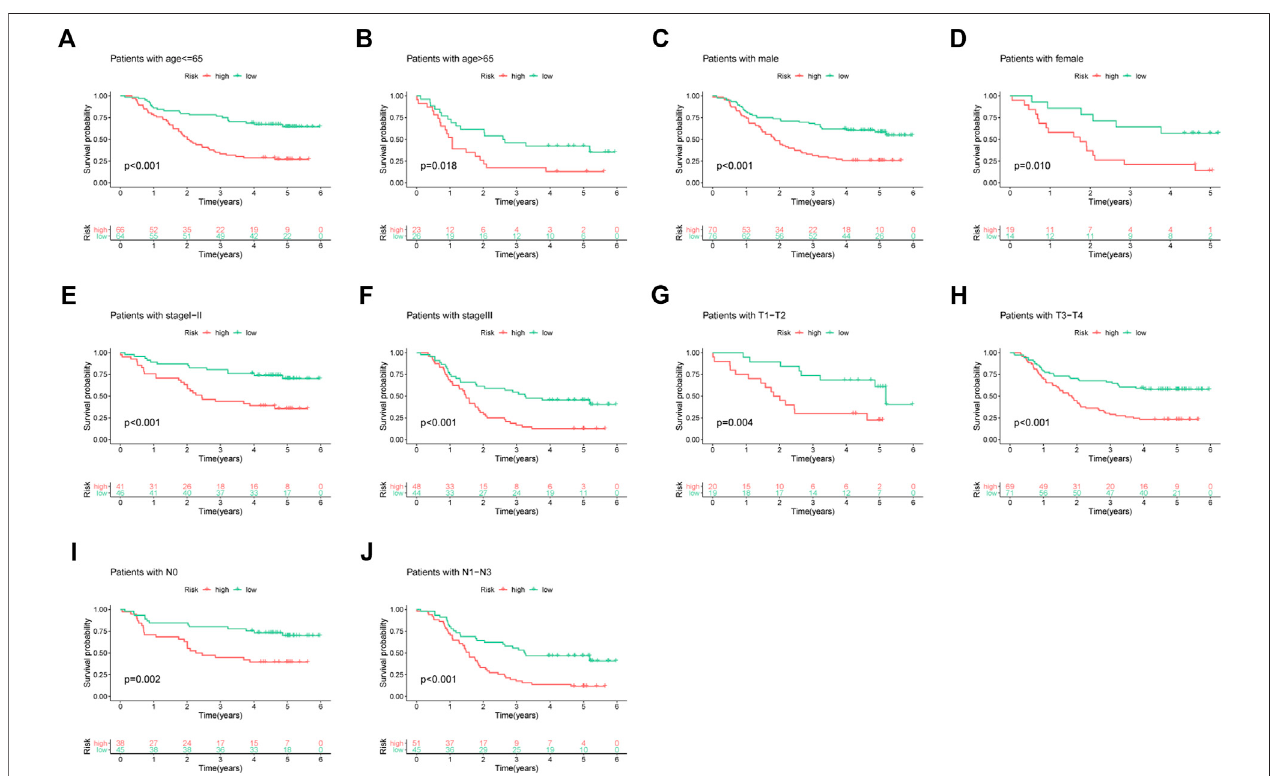
FIGURE3| SubgroupanalysesbasedondifferentclinicalfeaturesofESCCcases: (A) age ≤ 65, (B) age > 65, (C) male, (D) female, (E) stageI-II, (F) stageIII, (G) T1- T2, (H) T3-T4, (I) N0, and (J) N1 –